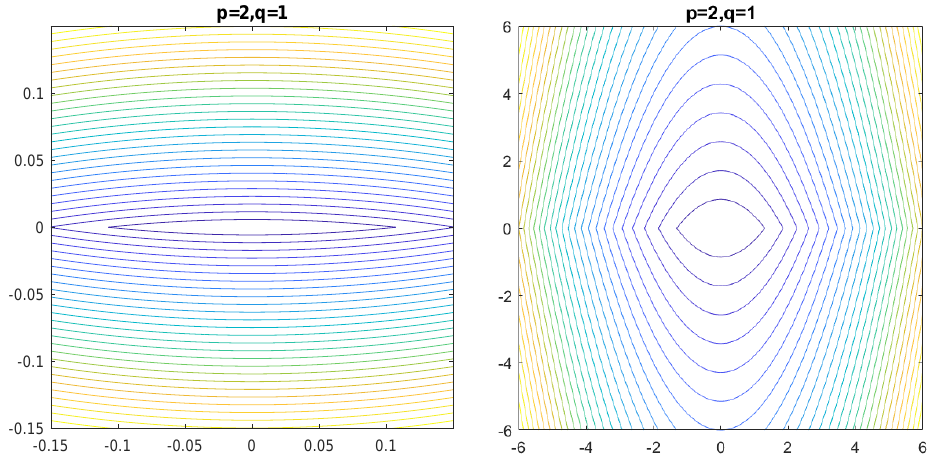
Figure 9. [ p , q ] -circles C [ p , q ] ( r ) for smaller and larger [ p , q ] -radii show change of shape and orientation as r changes.